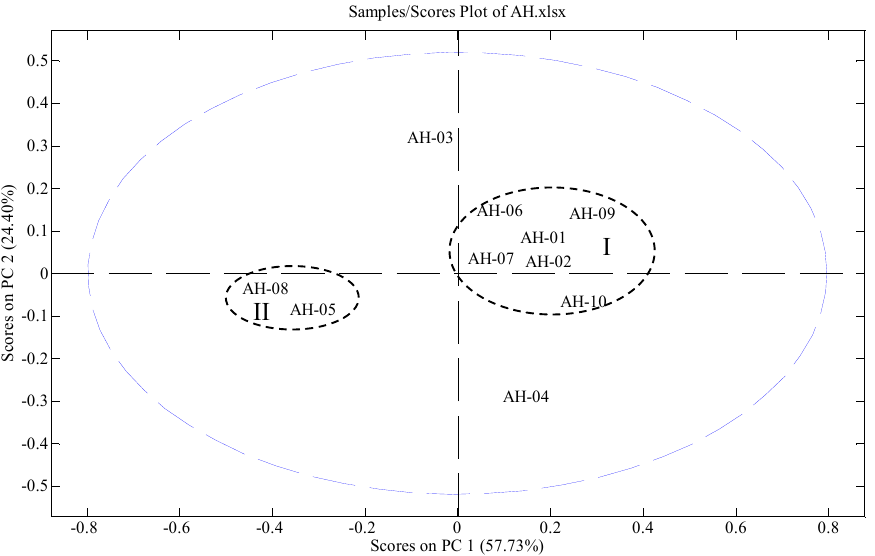
Figure 2. PCA scores plot of AH